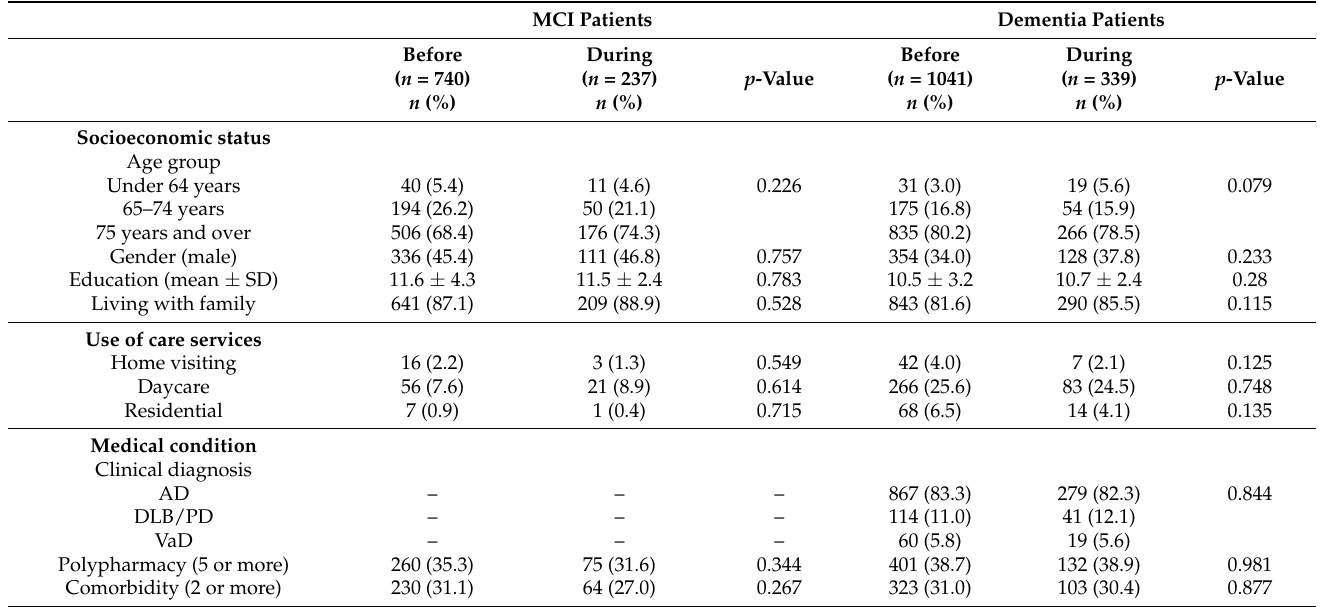
Table 1. Basic characteristics of participants before and during the COVID-19